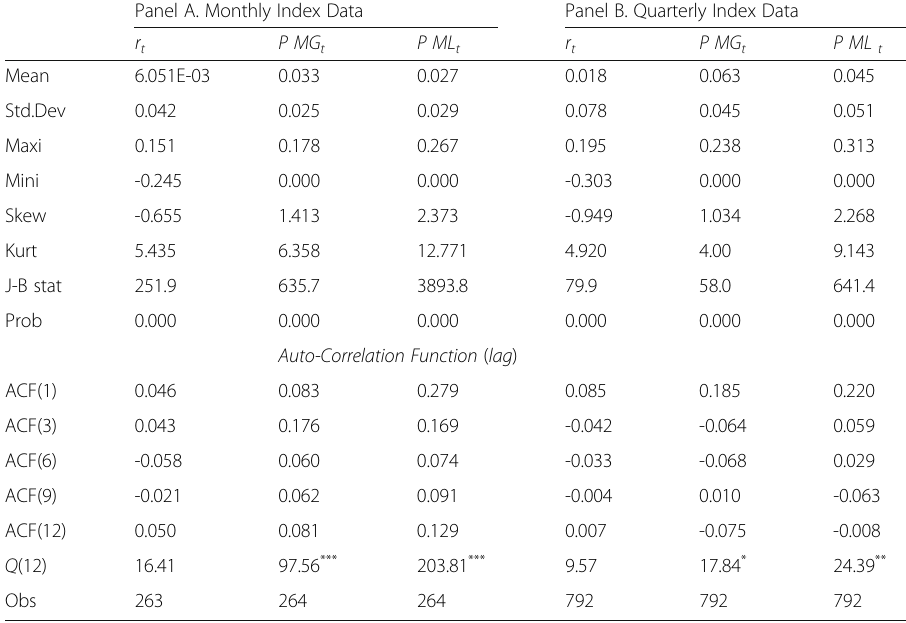
Table 1 Summary Statistics on Stock Returns, Potential Maximum Gains, Potential Maximum Losses Panel A. Monthly Index Data